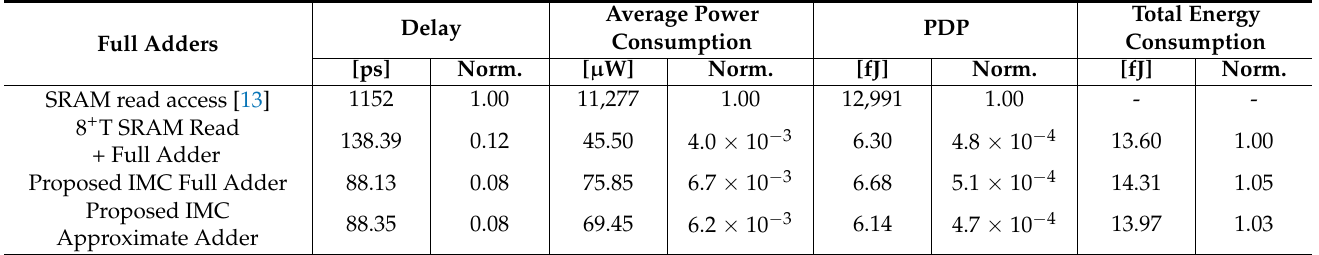
Table 3. Comparison of the performance and energy consumption in different full adders.